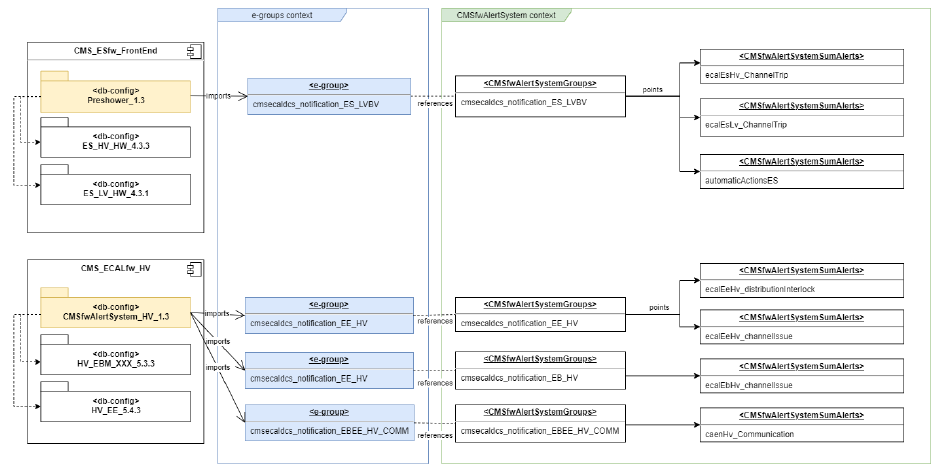
Fig. 4. Organization of the notification system for the ECAL HV and Preshower powering